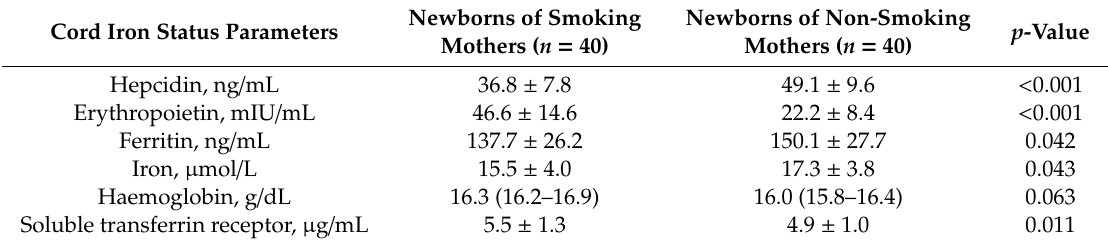
Table 2. Concentrations of hepcidin and selected iron parameters in